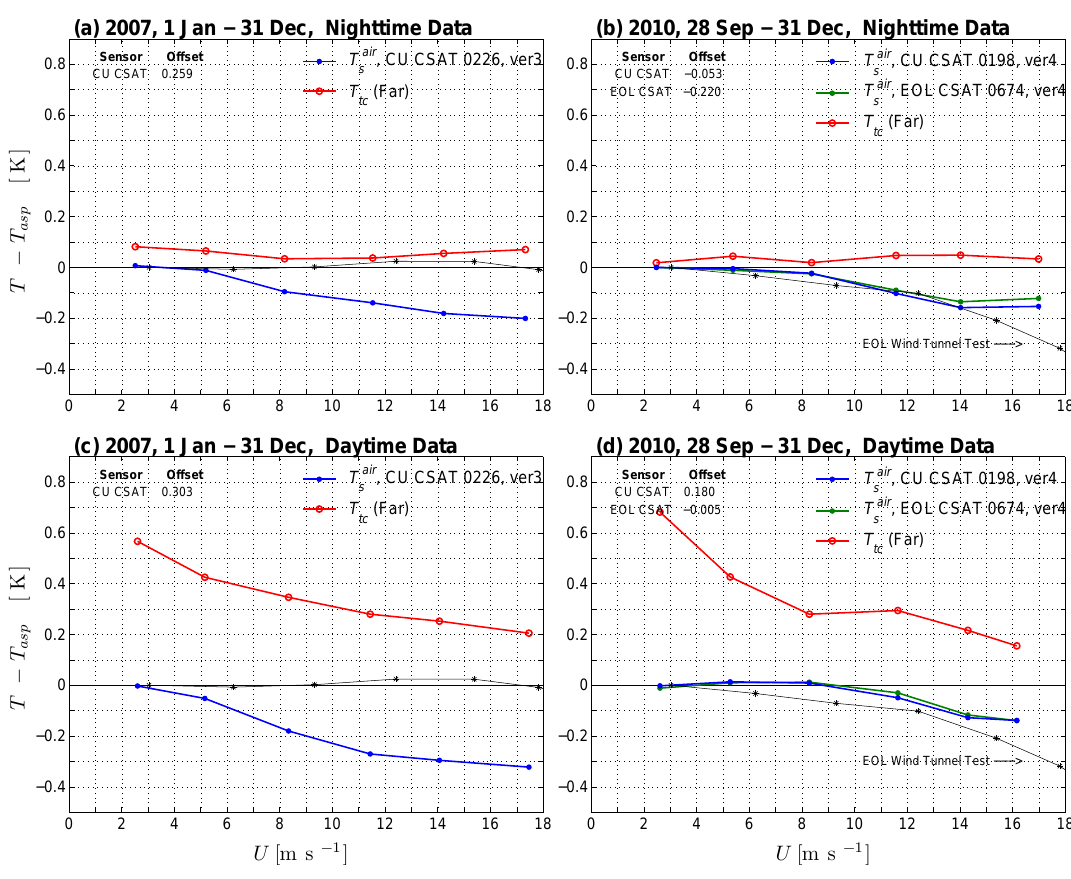
Fig. 8. The (a, b) nighttime and (c, d) daytime mean temperature difference ( T − T asp ) versus 21.5m horizontal wind speed U . T asp is measured within a mechanically aspirated housing, and T is from either a humidity-corrected CSAT ( T air s ) or a thermocouple ( T tc ) as specified in the legend (also see Table 1). Only periods with U > 1ms − 1 are used. T air s has been adjusted to T asp using an offset determined for 1 <U < 4ms − 1 , which is shown in the upper left corner of each panel. The time period used is shown above each panel. The black lines are the ver3 (left panels) and ver4 (right panels) wind tunnel data shown in Fig.